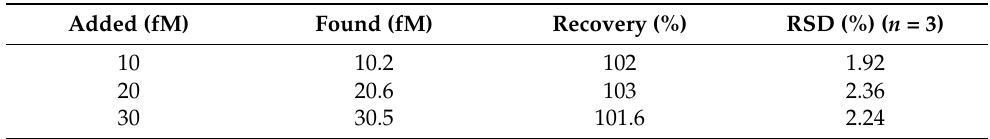
Table 1. Electrochemical detection of IL8 spiked in diluted human serum samples using Anti- IL8/MoS 2 /ZnO composite modified GCE as a sensor.